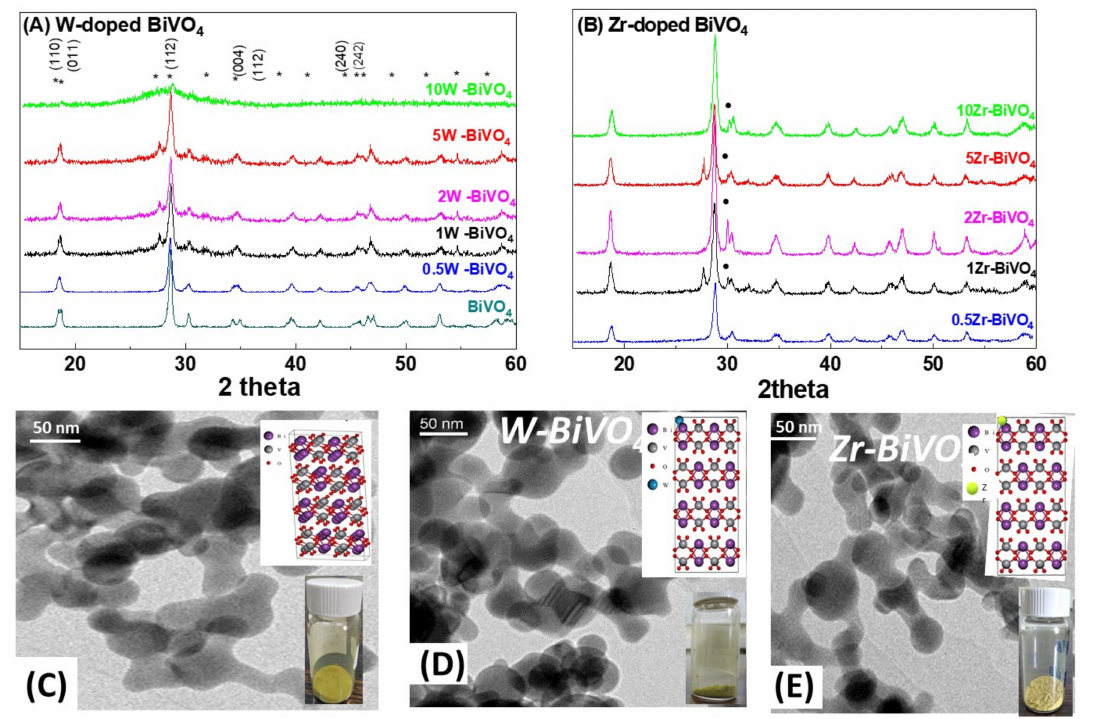
Figure 1. XRD patterns (upper row, W-doped ( A ) and Zr-doped ( B )), and TEM images (lower row) for BiVO 4 ( C ), 5W-BiVO 4 ( D ) and 5 Zr-BiVO 4 ( E ). Inserts in C-E: photos of the nanopowders and atomic structure of the materials. In figure also presented the miller index of BiVO 4 structure. In (A), stars (*) mark the main Miller-planes of BiVO 4 . In (B) the dots ( • ) mark ZrO 2